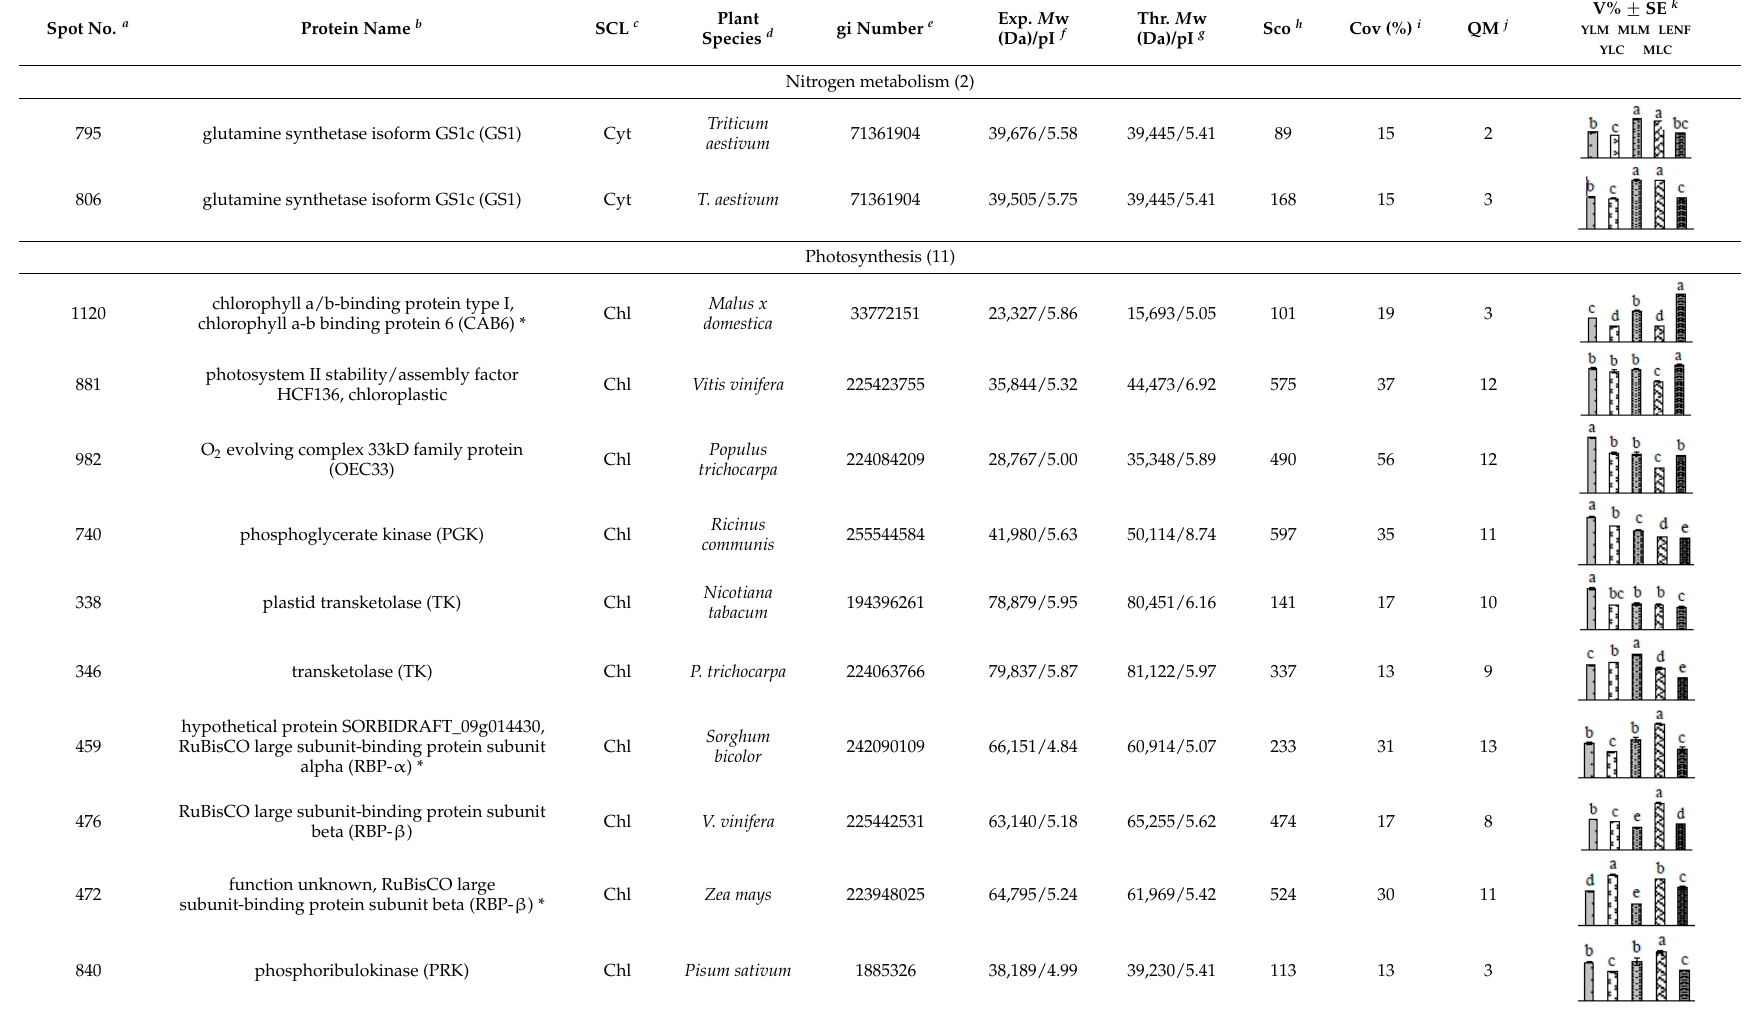
Table 1. Identified differentially expressed proteins of various leaf regions at different development stages of Hosta “Gold Standard”. Spot